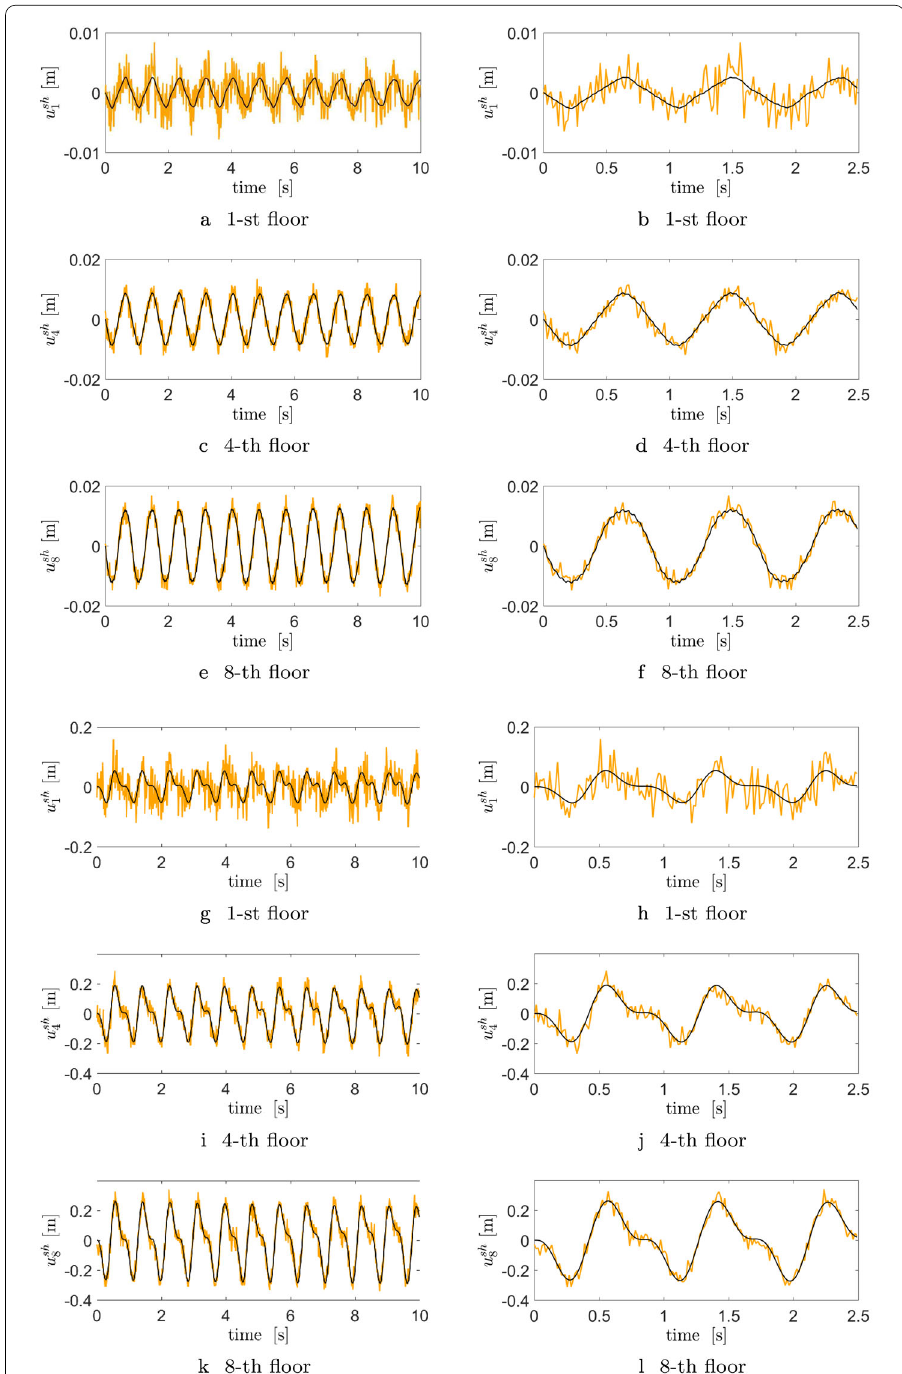
Fig. 7 Example of time evolutions of x displacements for stories 1 , 4 , 8 with SNR = 15 dB (from a – f ) and = ( 21 . 1 , 69 . 2 ) , γ sh = ( − 0 . 058 , − 0 . 199 ) . SNR = 10 dB (from g – l ), undamaged state. Low-noise case: f sh 1 , 2 1 , 2 = (14 . 5 , 2 . 36), γ sh = (0 . 025 , − 0 . 159). Orange lines represent u , whereas black lines stand High-noise case: f sh 1 , 2 1 , 2 for r , according to Eq. (2). On the right side, a closer view for each left side plot is